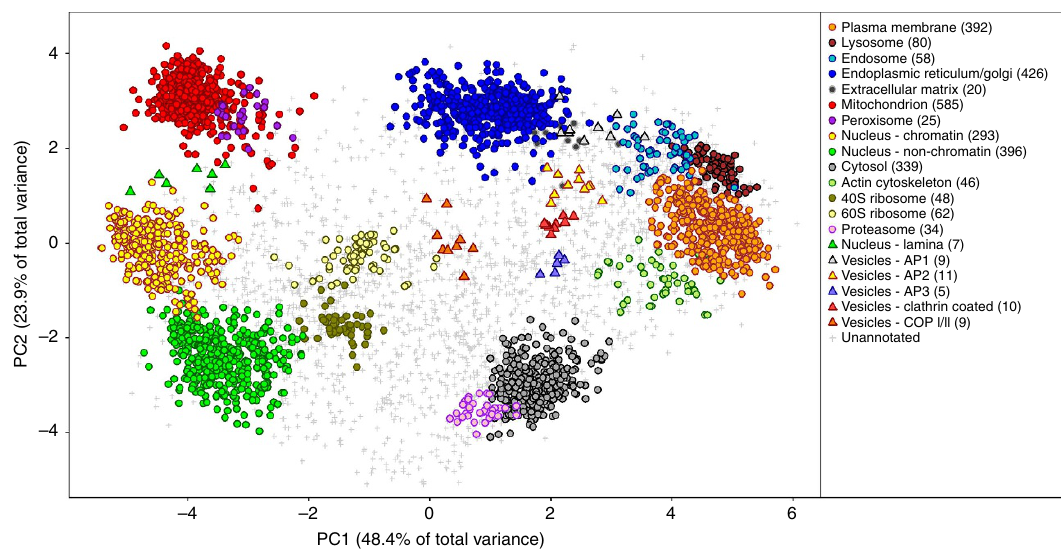
Figure 3 | PCA representation of E14TG2a mouse ES cell hyperLOPITdata. Each data point represents a protein group, and proteins with correlated TMT reporter ion distributions cluster together in PCA space. Coloured circles represent subcellular compartments that have been classified by SVM and coloured triangles represent smaller organellar phenotypes that were manually curated. While two dimensions describe much of the spatial resolution in these data, separation of some compartments, such as the mitochondrion and peroxisome, is only apparent in the lower principal components (Supplementary Fig.